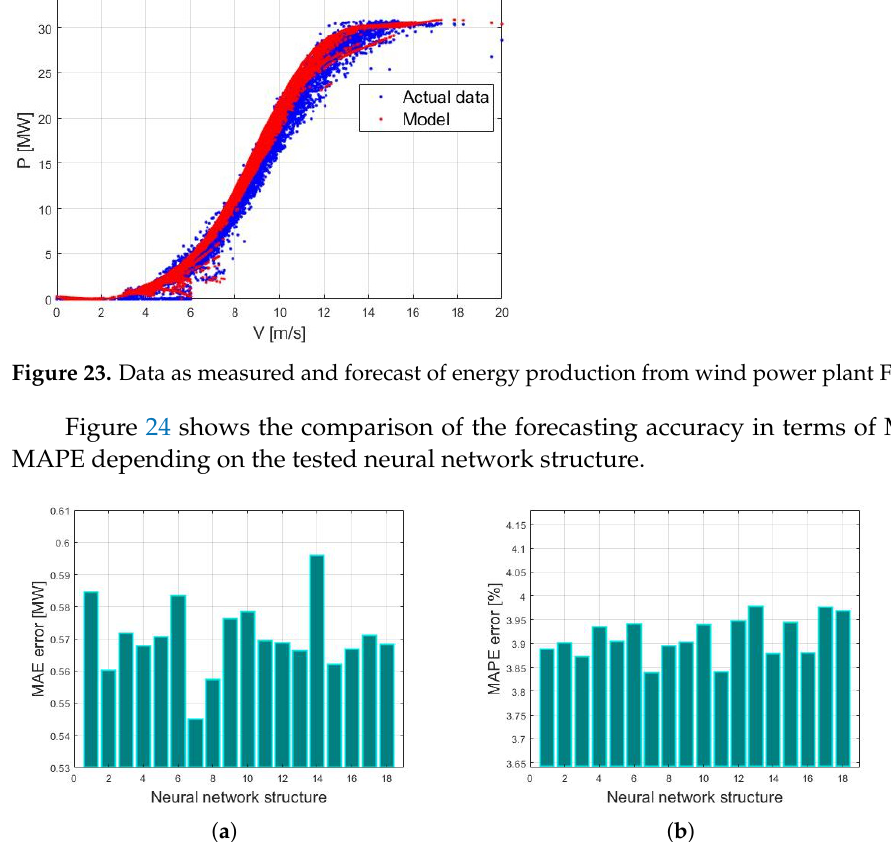
Figure 24. Summary of forecast accuracies by the selected neural network structure for wind power plant FW3. ( a ) MAE. ( b )